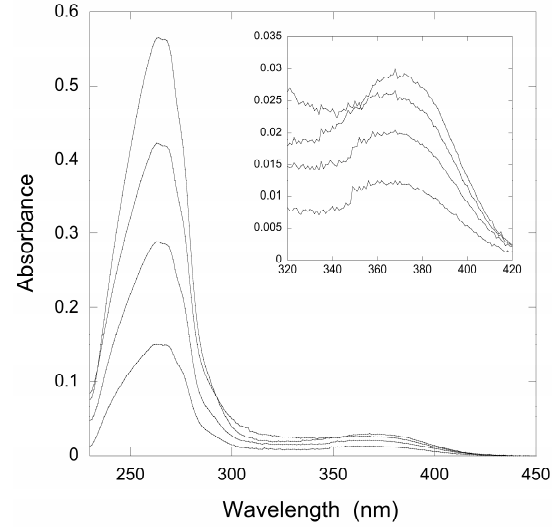
Figure 5. UV-Vis spectroscopy of a titration of QueF-L with preQ 0 -tRNA. The traces correspond, from bottom to top, to preQ 0 -tRNA concentrations of 1, 2, 3, and 4 µ M, respectively. QueF-L was present at a concentration of 20 µ M. Inset shows the region around 376 nm expanded for